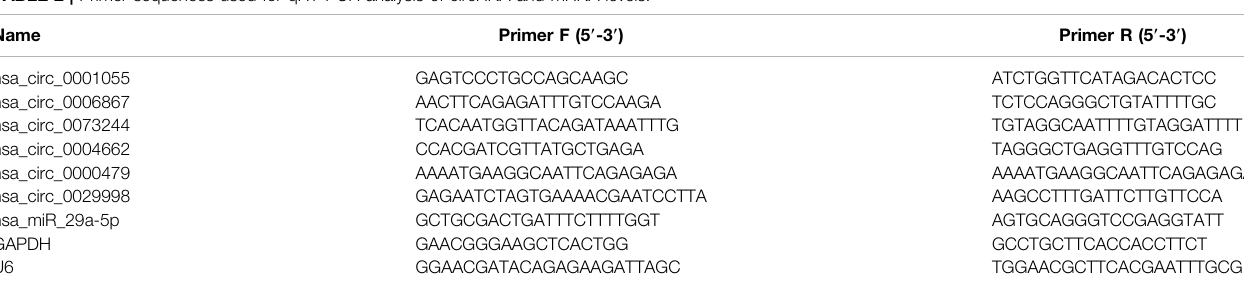
TABLE 2 | Primer sequences used for qRT-PCR analysis of circRNA and mRNA